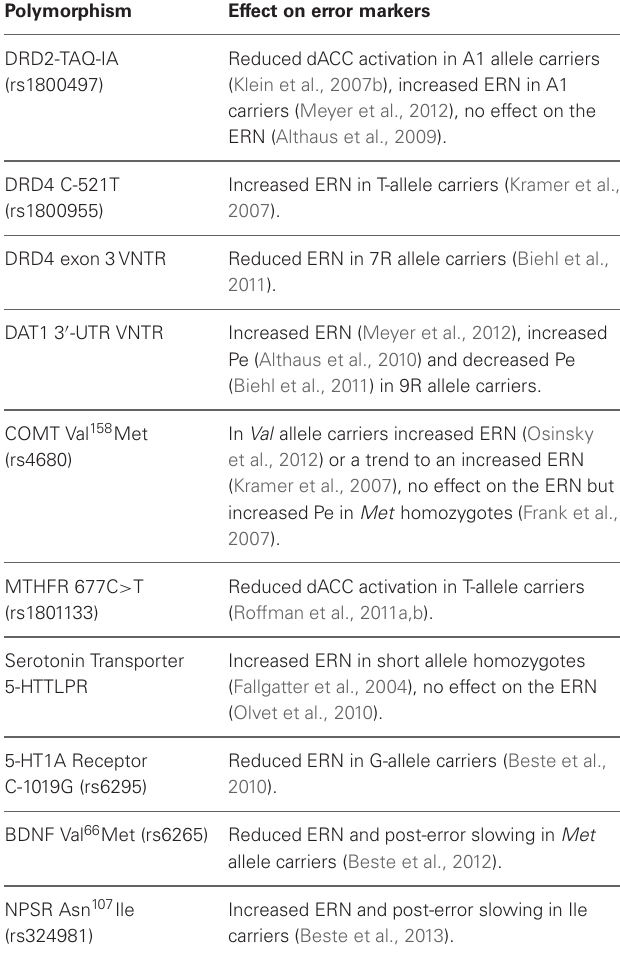
Table 1 | Genetic polymorphisms affecting EEG and fMRI error